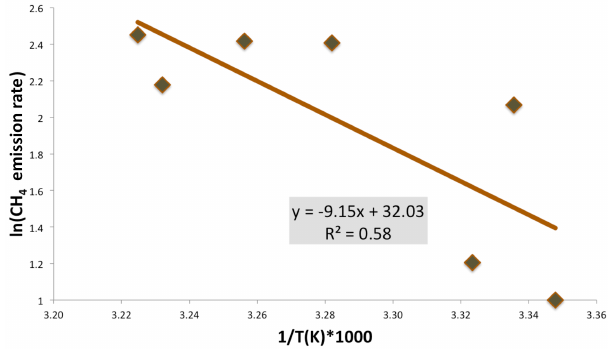
Figure 11. Arrhenius plot of the estimated methane emission rate from each flight and the average ABL temperature from the ArvinO3 study where methane emissions are believed to be domi- nated by agricultural